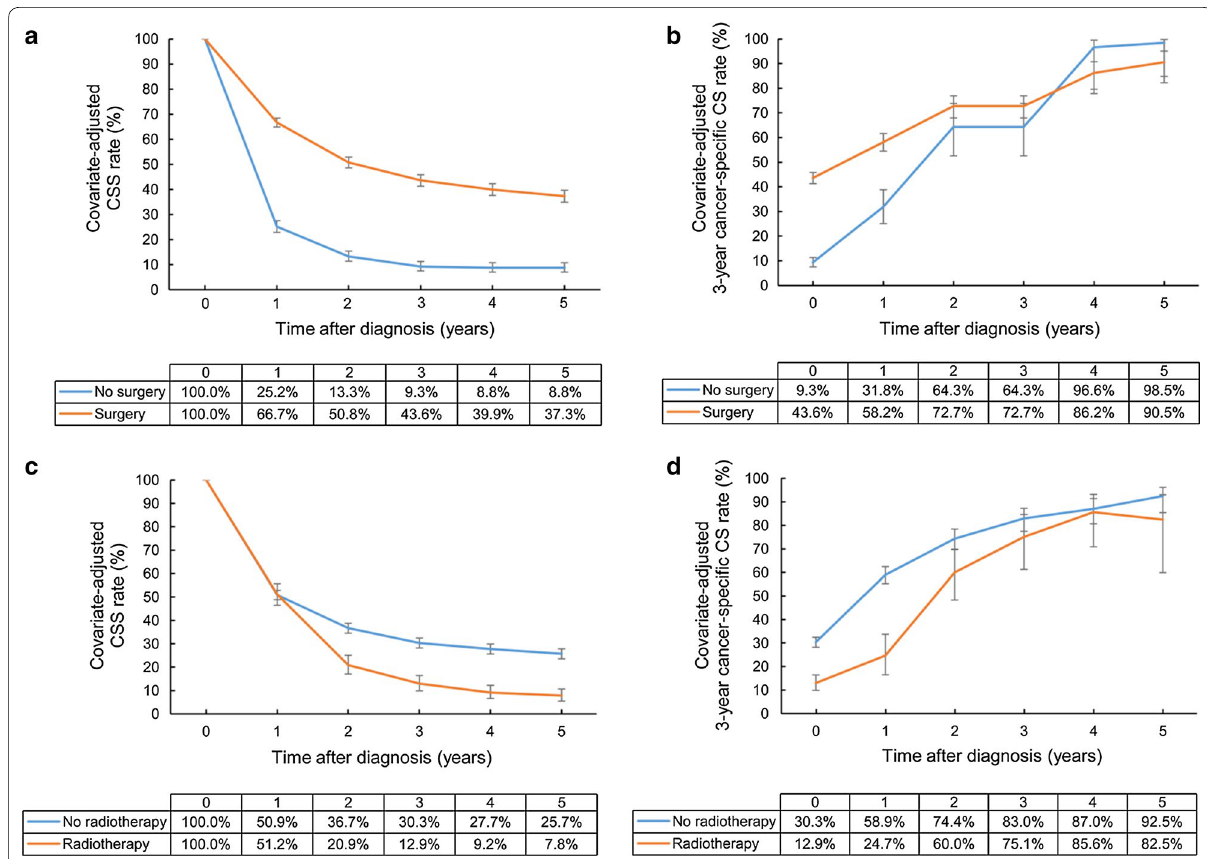
Fig. 3 Covariate‑adjusted (Cox model) CSS and 3‑year cancer‑specific CS rates of gallbladder cancer patients according to treatments: a CSS rates according to surgery; b cancer‑specific CS rates according to surgery; c CSS rates according to radiotherapy; d cancer‑specific CS rates according to radiotherapy. Error bars indicate 95% CIs. CSS cancer‑specific survival, CS conditional